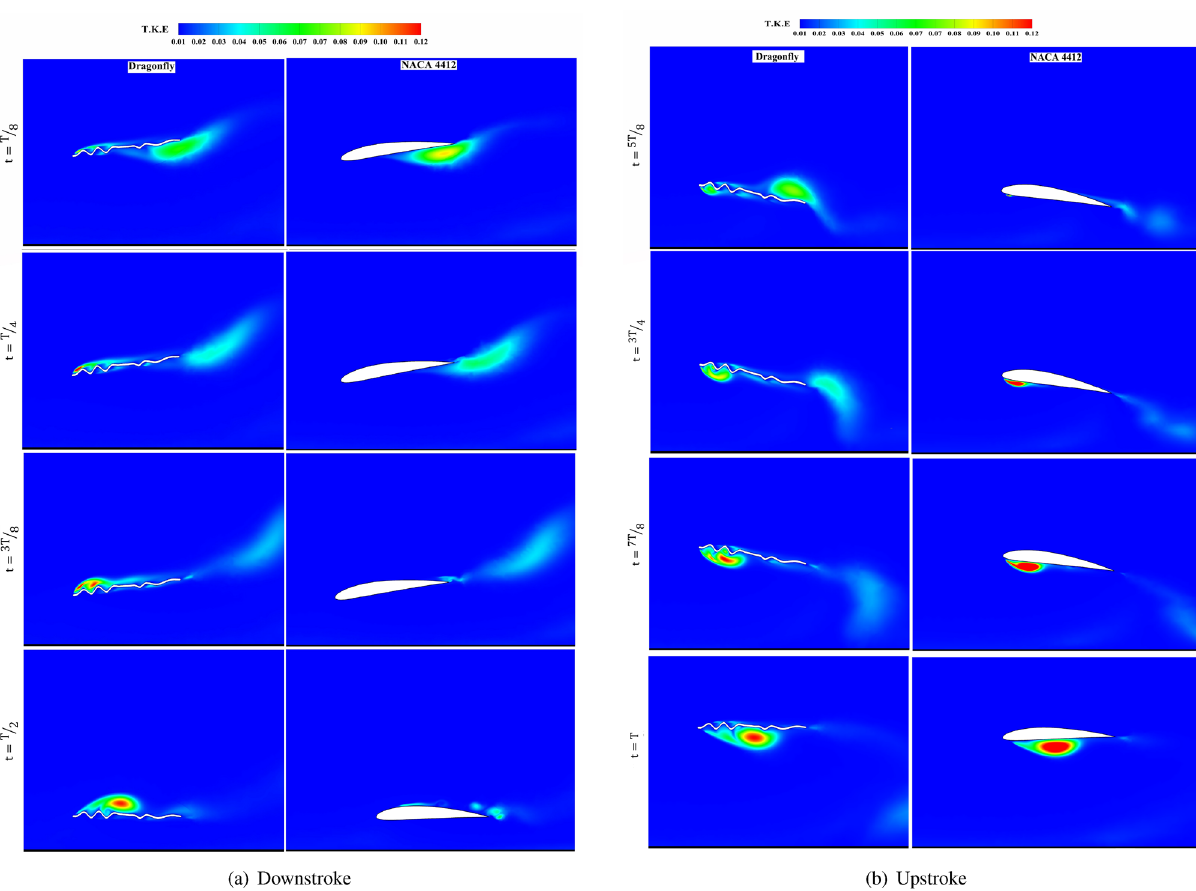
Figure 20. Contours of momentary turbulent kinematic energy (T.K.E) across a cycle with Re = 5 × 10 St = 0.6 for both dragonfly and NACA4412